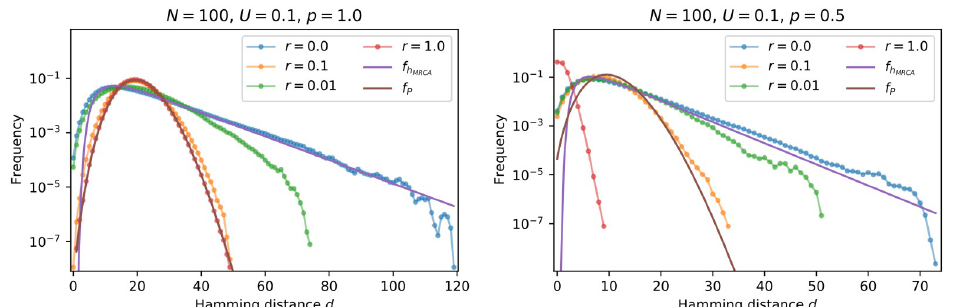
Fig 7. Cross section of the population cloud in the ism . Parameters are N = 100, U = 0.1 and p = 1.0 (left panel) vs. p = 0.5 (right panel). The figures show the distribution of the Hamming distance to the genotype containing only fixed mutations. The hypoexponential distribution f is given by Eq 18 and f is a Poisson distributions with mean θ � . P h MRCA The data were accumulated over 10 6